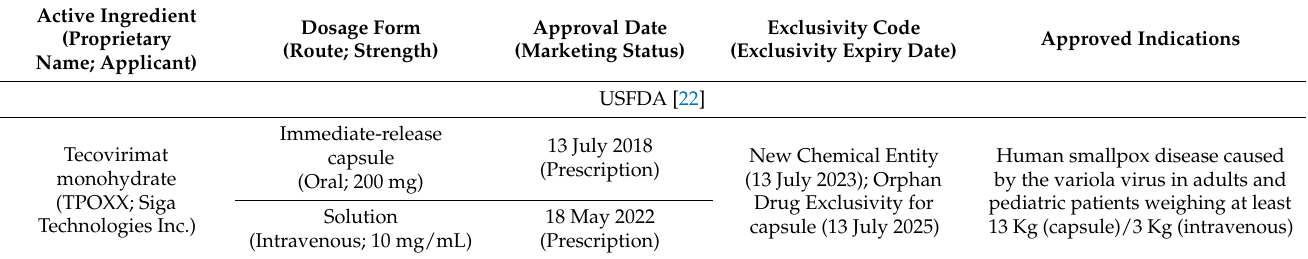
Table 1. R x data of the EMA, USFDA, and Health Canada approved